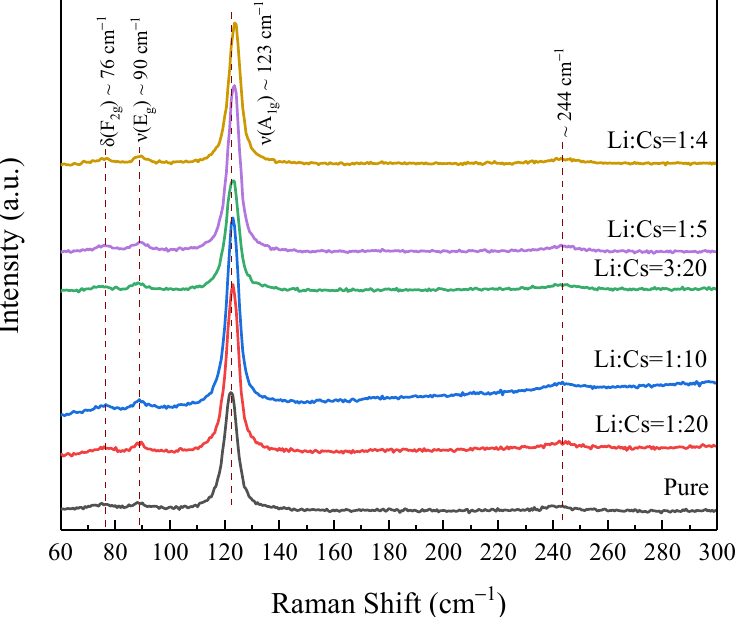
Figure 8. Raman spectrums of undoped Cs 2 SnI 6 and Li + doped Cs 2 SnI 6 with different concentrations.